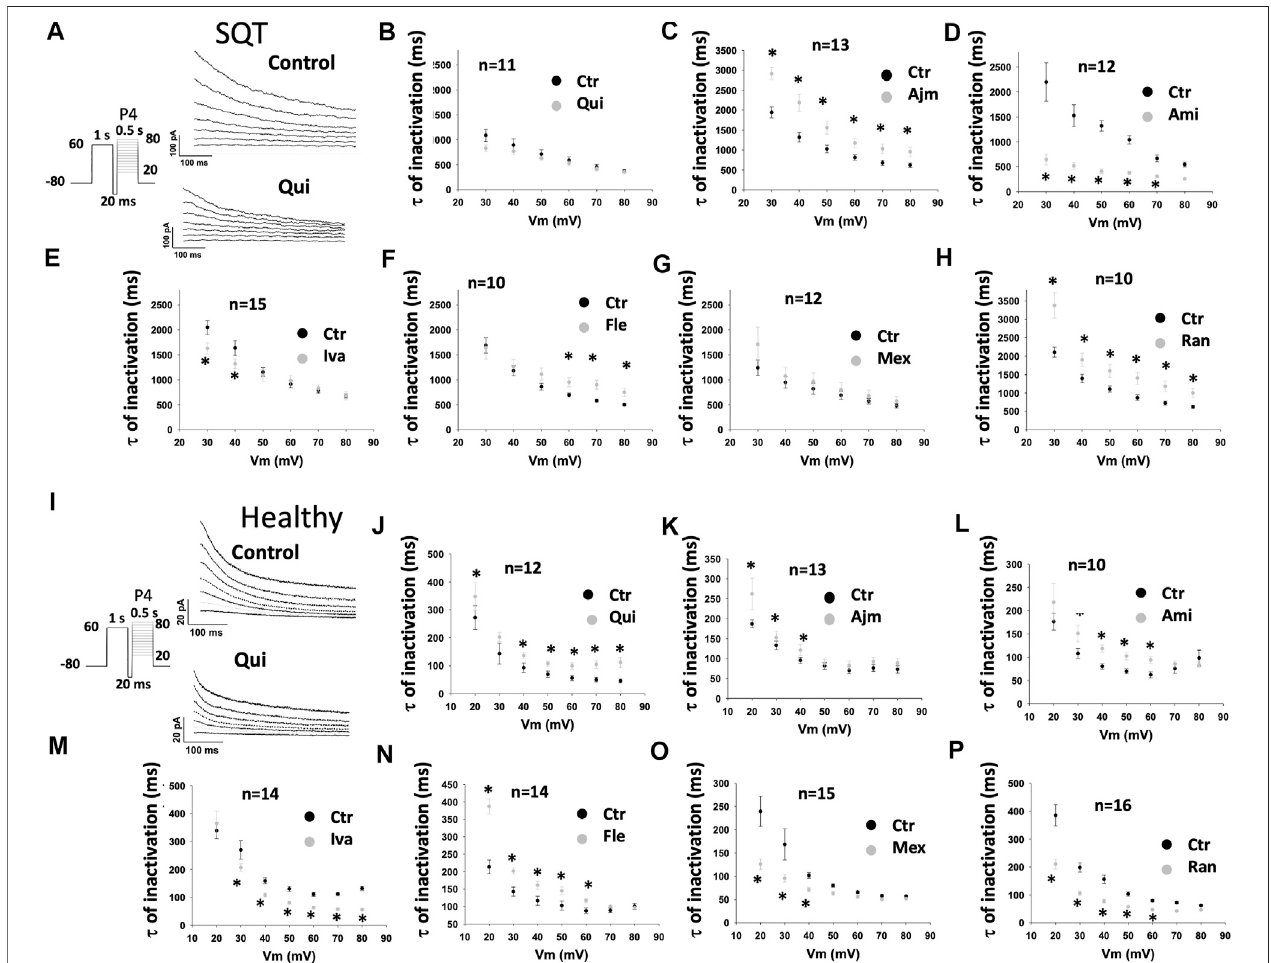
FIGURE5| Drugeffects onthetimeconstantofI Kr inactivation inSQTS1-hiPSC-CMs. Toexaminedrug effects onthefastphaseofinactivation, I Kr wasevokedby a 1 s-long pre-pulse from − 80 to 60 mV to let hERG channels be activated and returned to − 100 mV for 20 ms, and then the pre-pulse was followed by 500 ms test- pulses [P4intheprotocolshown bytheinsetin (A) and (I) ]from20to80 mV(10 mVincrements).Currentsevokedbytest pulseswere fi ttedbysingleexponentialdecay toobtainthetimeconstant( τ )ofI Kr fastinactivation. (A) RepresentativetracesofI Kr evokedbypulsesfrom20to80 mVinabsence(Control)andpresenceof10 µM quinidine (Qui) in a SQT1-hiPSC-CM. (B – H) Mean values of time constants ( τ ) of I Kr inactivation in SQT1-hiPSC-CMs in absence (Ctr) and presence of quinidine (Qui, 10 µM), ajmaline (Ajm, 30 µM), amiodarone (Ami, 10 µM), ivabradine (Iva, 10 µM), fl ecainide (Fle, 30 µM), mexiletine (Mex, 100 µM) and ranolazine (Ran, 30 µM). (I) Representative tracesof I Kr evoked bypulses from 20 to80 mV inabsence (Control) and presence of 10 µM quinidine (Qui) in a donor-hiPSC-CM. (J – P) Mean values of time constants ( τ ) of I Kr inactivation in donor-hiPSC-CMs in absence (Ctr) and presence of each drug. Shown are mean ± SEM, n represents number of cells. The statistical signi fi cance was examined by paired t-test, * p < 0.05 versus